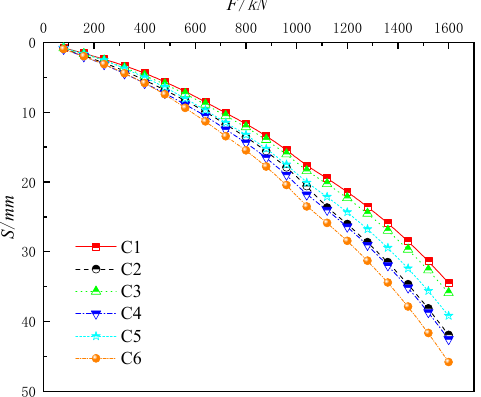
Figure 3. The field static load–displacement curve.